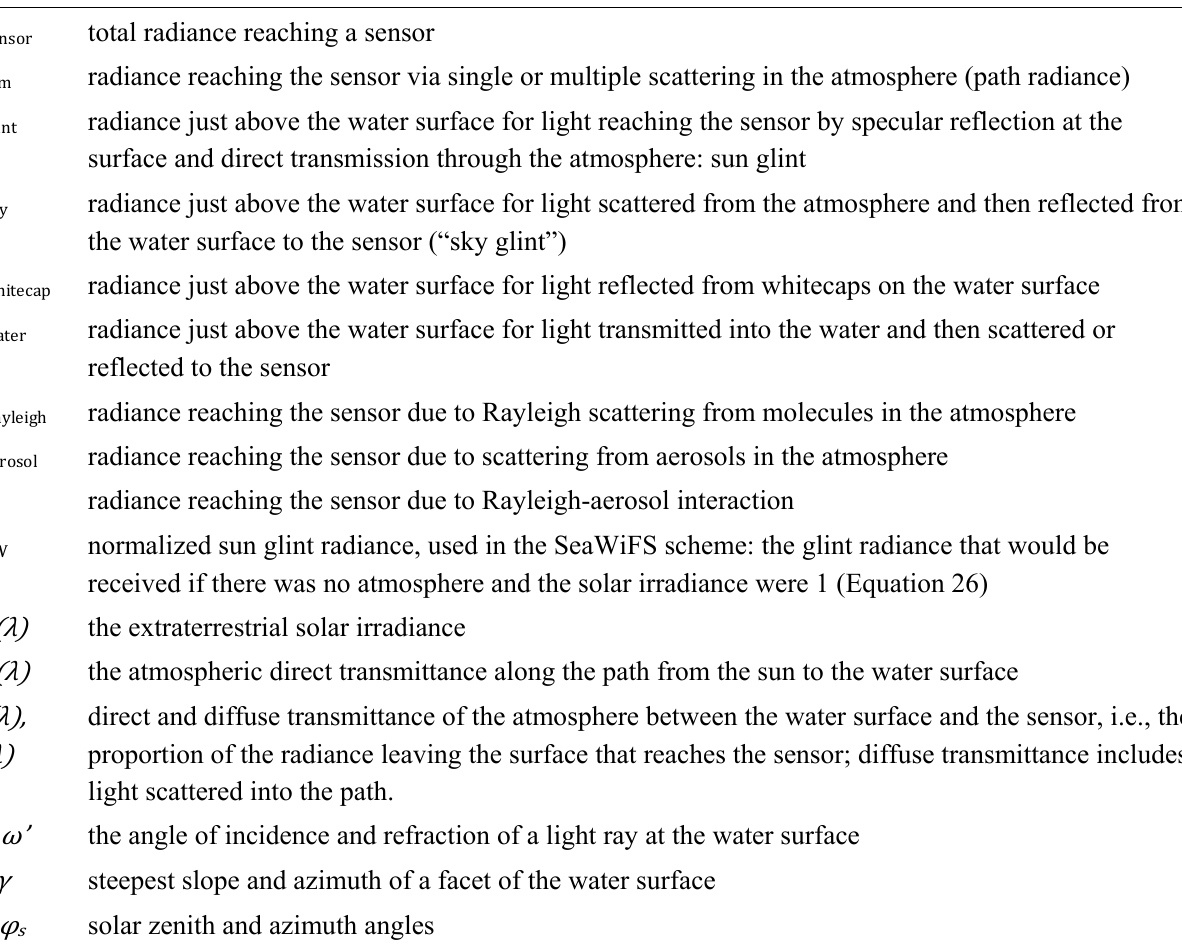
Table 2. Nomenclature used in